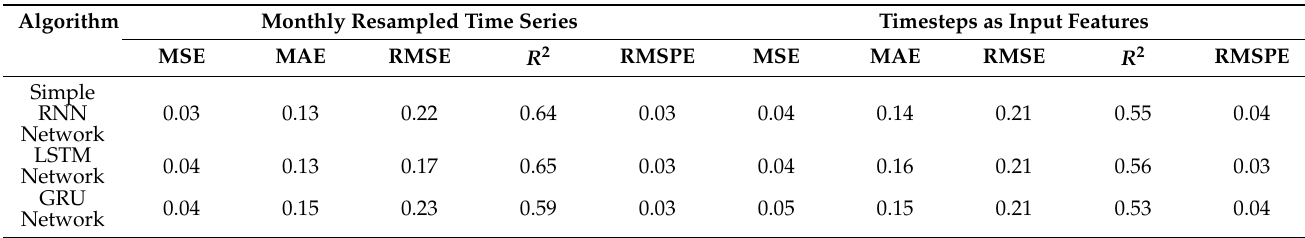
Table 7. Results when forecasting from all numerical OCT features, from one previous